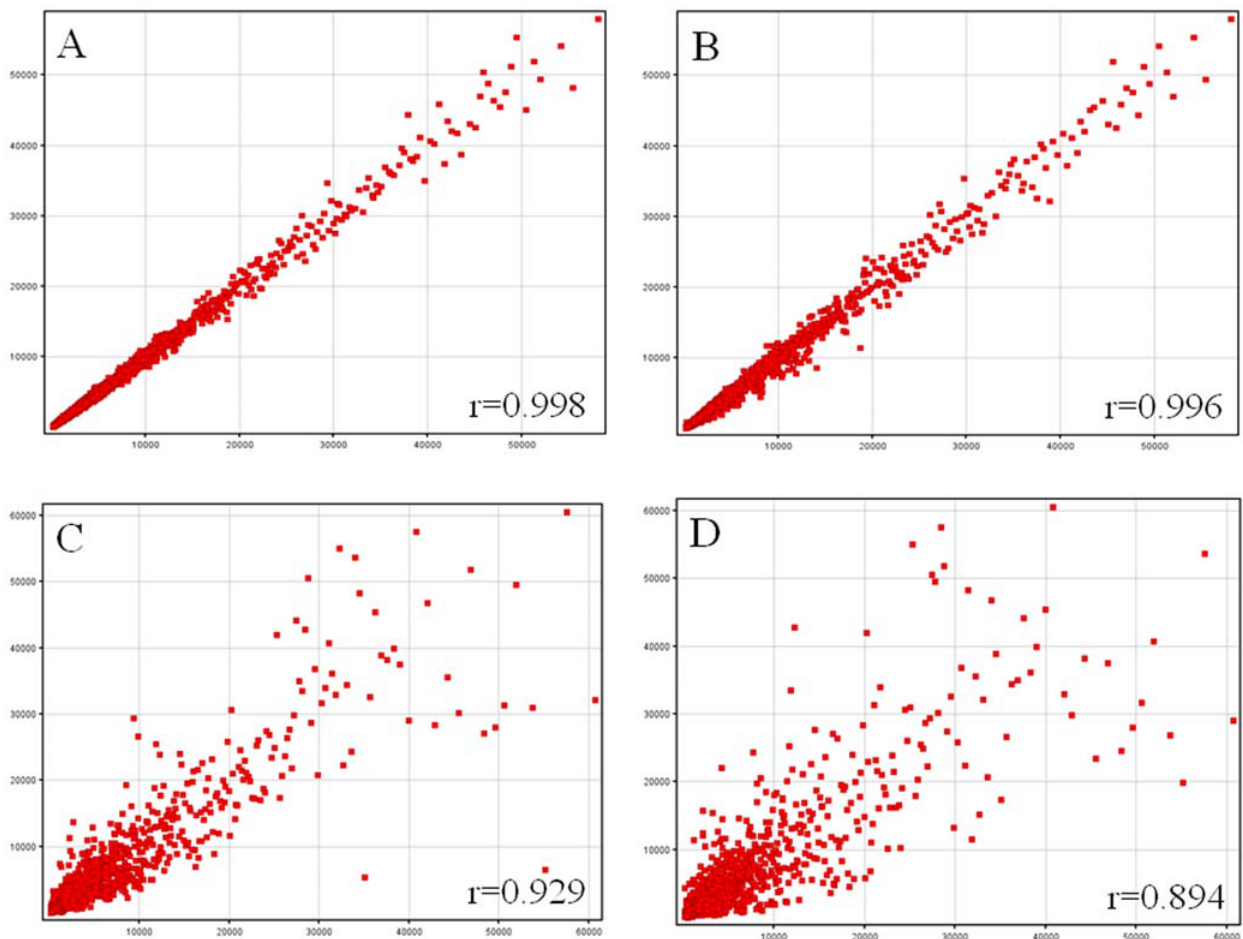
Figure 1. Scatter plots representation of signal intensities. Scatter plot of technical replicates: (A) same reference RNA undergoing two different hybridization or (B) same reference RNA from two different labeling runs. Typical scatter plots of data obtained from two patients (C) or a patient and a control (D). Pearson correlation coefficient is indicated in each scatter plot.